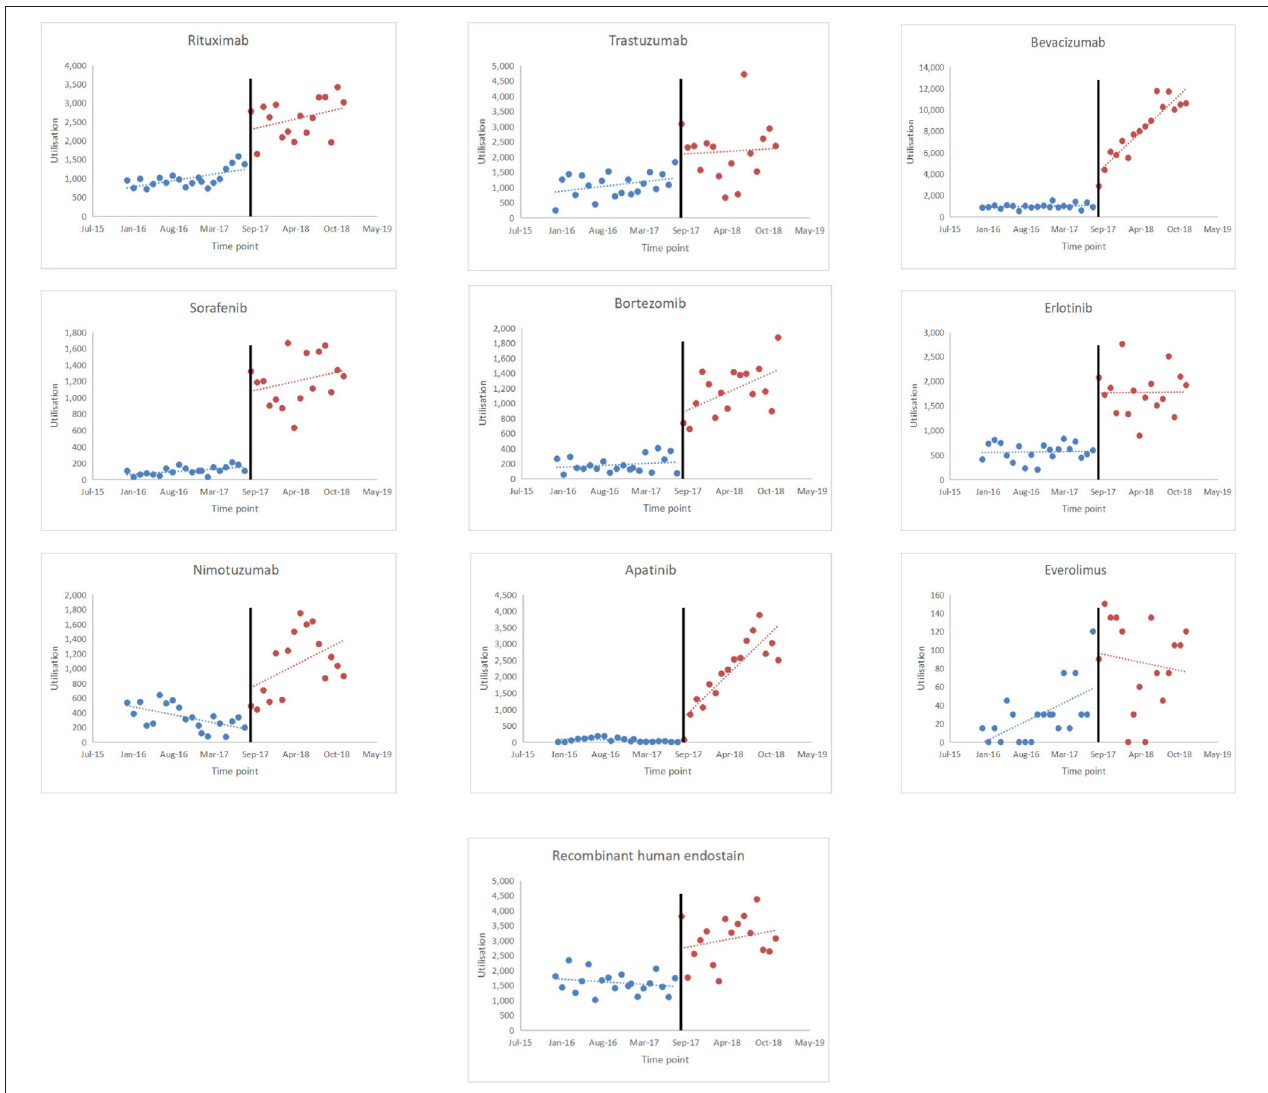
FIGURE 2 | Results of the regression analysis of the utilisation of study drugs before and after policy implementation shown in a scatter plot.